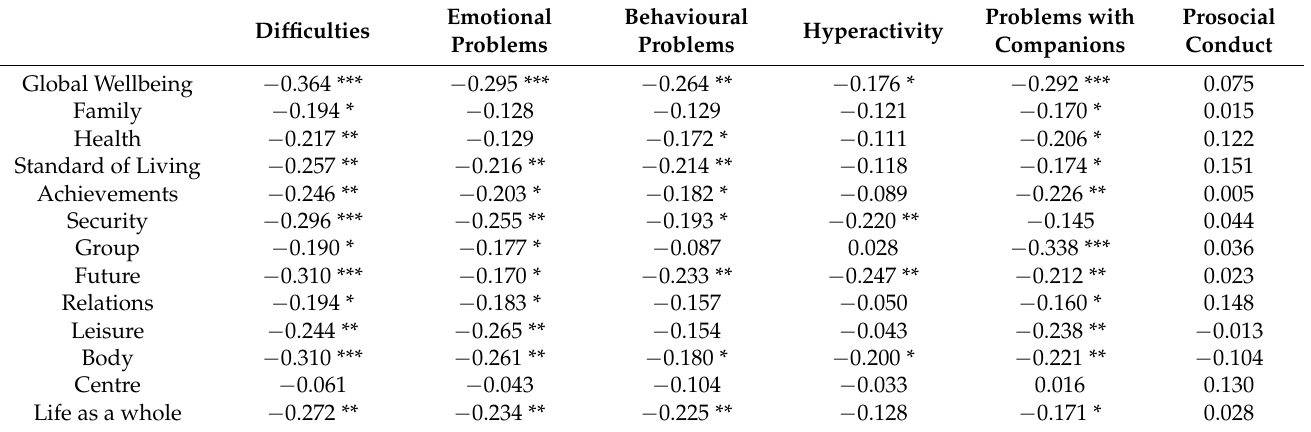
Table 4. Correlations between the adolescents’ emotional and behavioural difficulties and their personal